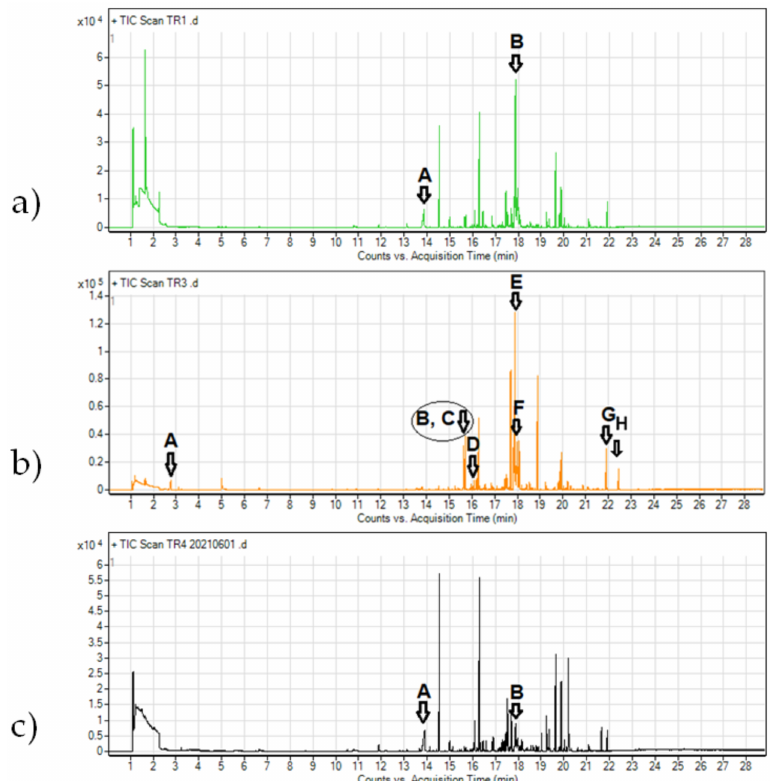
Figure 4. HS-GC-MS profiles of VOCs emitted by Trichoderma isolates: ( a ) Trichoderma sp. DEMf TR1: A: Nonanoic acid, B: Trichoacorenol; ( b ) T. citrinoviride DEMf TR3: A: Acetic acid, B: Cubenene, C: Cubenene, D: cis- α -bergamotene, E: Trichoacorenol, F: Trichoacorenol, G: Verticillol, H: Hexanedioic acid, bis(2-ethylhexyl) ester; ( c ) T. citrinoviride DEMf TR4: A: Nonanoic acid, B: